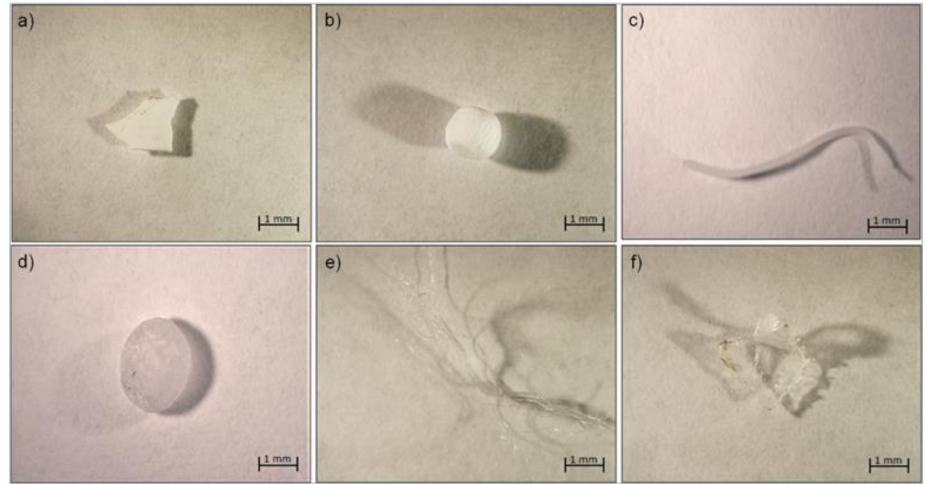
Figure 3. Examples of microplastics with different sizes and shapes: ( a ) fragment, ( b ) foam, ( c ) line, ( d ) pellet, ( e ) fiber, ( f )